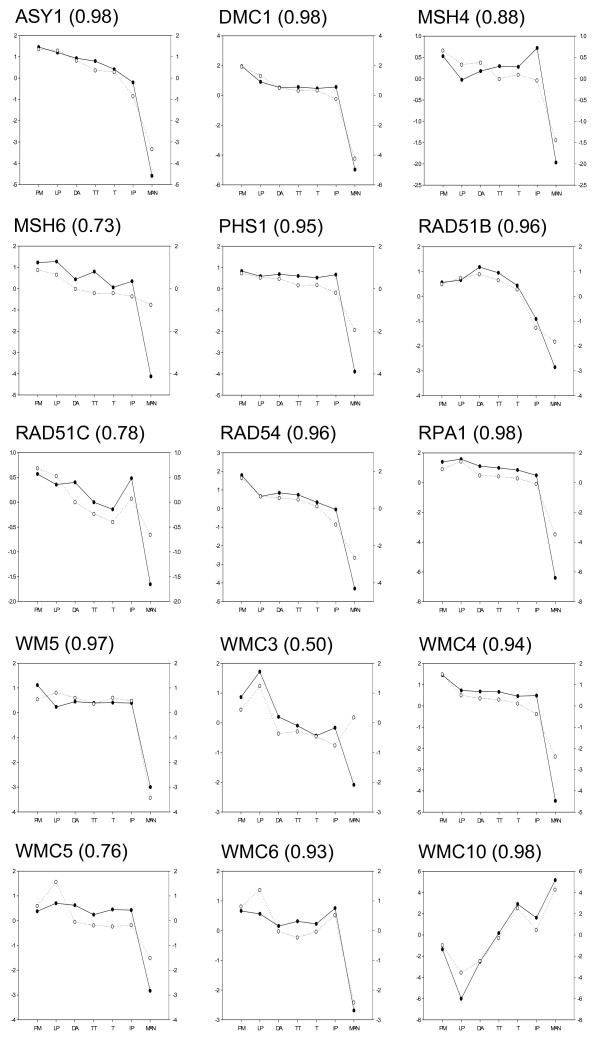
Correlation of the microarray profile with the Q-PCR data from the corresponding transcript. Lines with the open circles represent microarray data, while lines with solid circles represent the Q-PCR data. The data for each transcript from the microarray is log base 2, RMA normalized and centered about its average across the seven stages, while the data for the Q-PCR is log base 2, normalized mRNA copies/μL and centered. Correlation values for each of the transcripts investigated using both technology platforms are indicated.